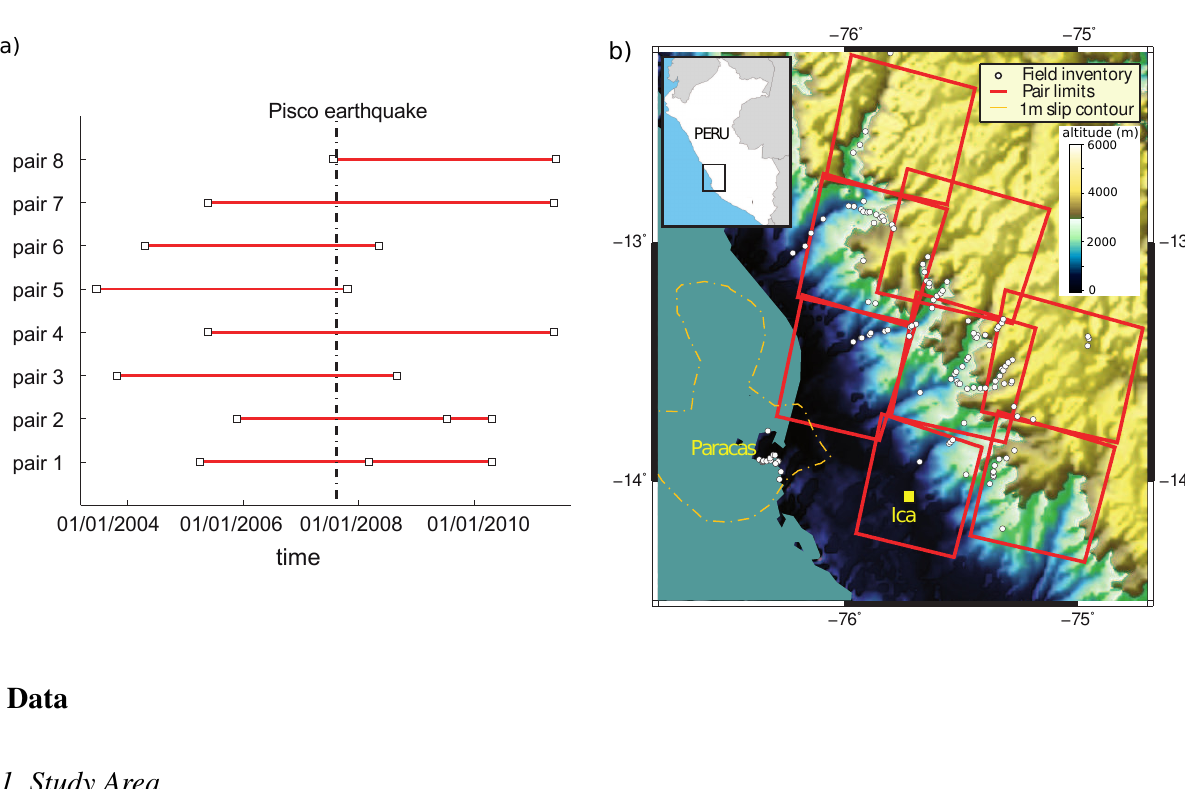
Figure 1. Summary of the SPOT5 image pairs used in this study: ( a ) temporal baseline and ( b ) corresponding images coverage. The 1 m contour of slip distribution on the fault during the Pisco earthquake (orange line) is extracted from Sladen et al. [37]. The white dots represent the landslides identified with the field inventory